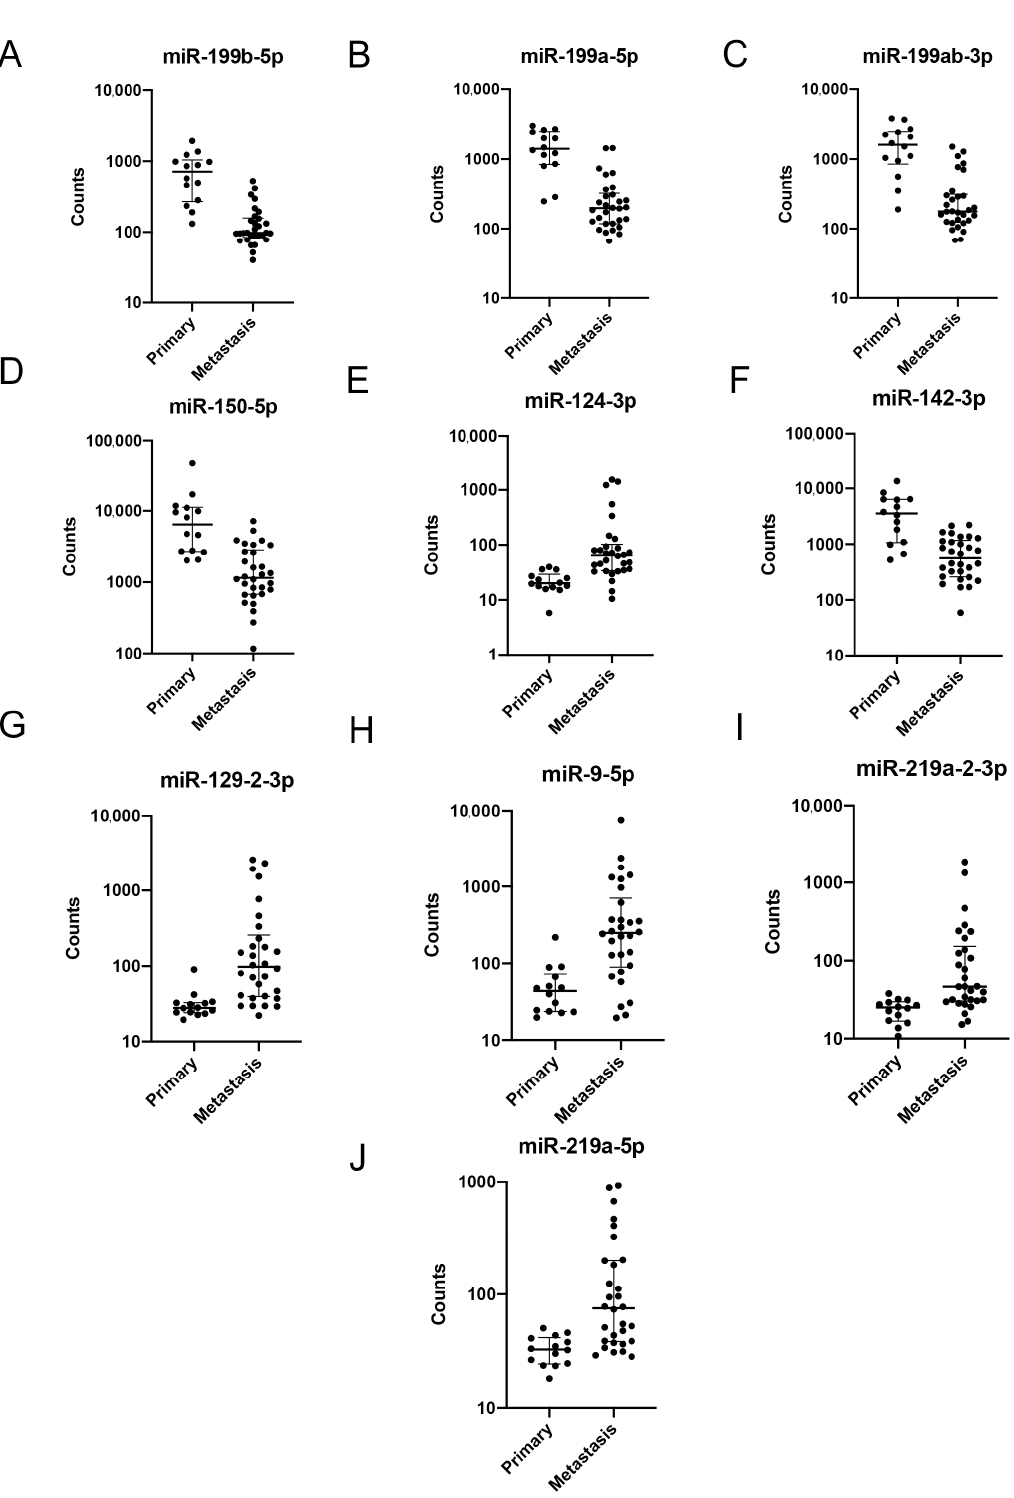
Figure 3. Expression of differentially expressed miRNAs in primary NSCLC versus brain metas- tasis. ( A – J ) Normalized counts of differentially expressed miRNAs comparing primary NSCLC versus brain metastasis. All displayed miRNAs were differentially expressed with a false discovery rate adjusted p -value of <0.05. miRNAs from the miR-199 family displayed the most significant differential